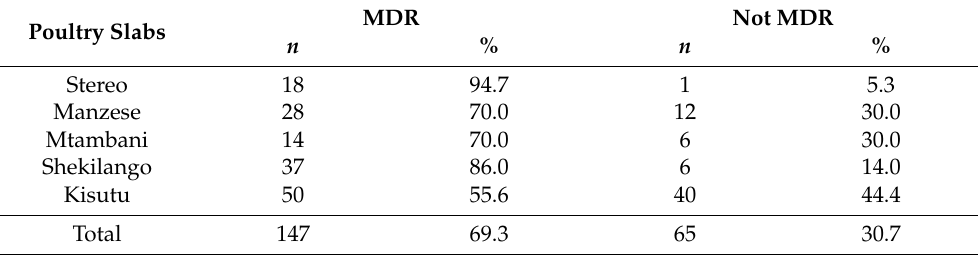
Table 1. Frequency of MDR and non-MDR Escherichia coli isolated from the selected poultry slabs in Dar es Salaam ( n = 384).